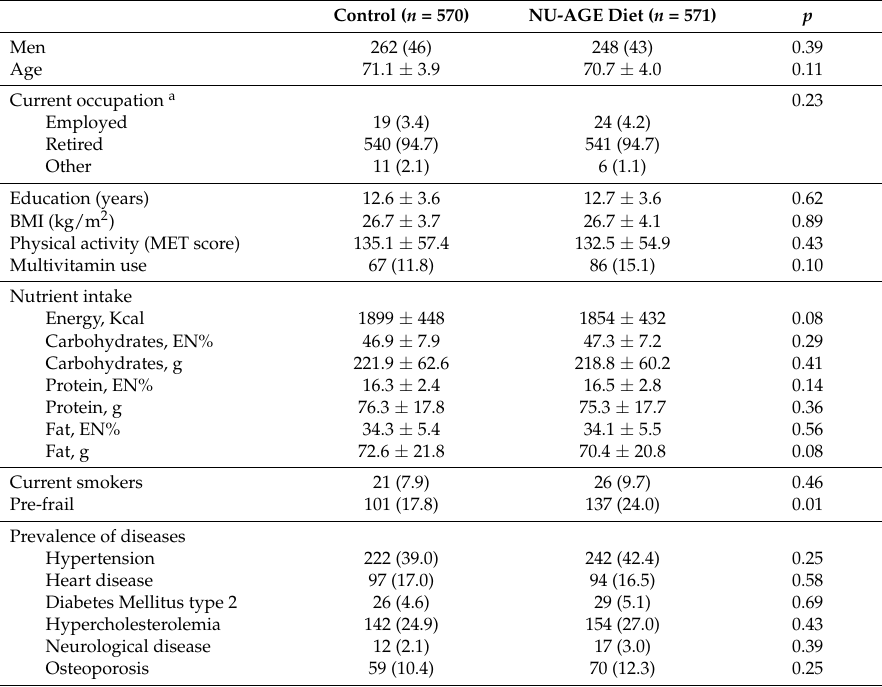
Table 2. Baseline characteristics of the NU-AGE participants by intervention group ( n =